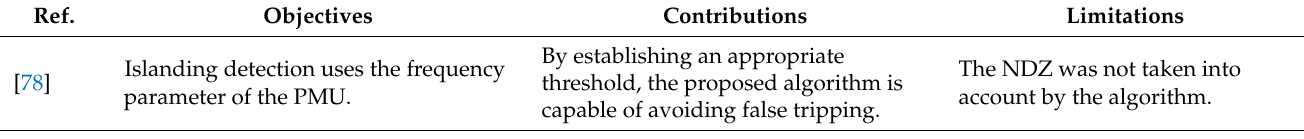
Table 2. Islanding detection algorithms using PMU